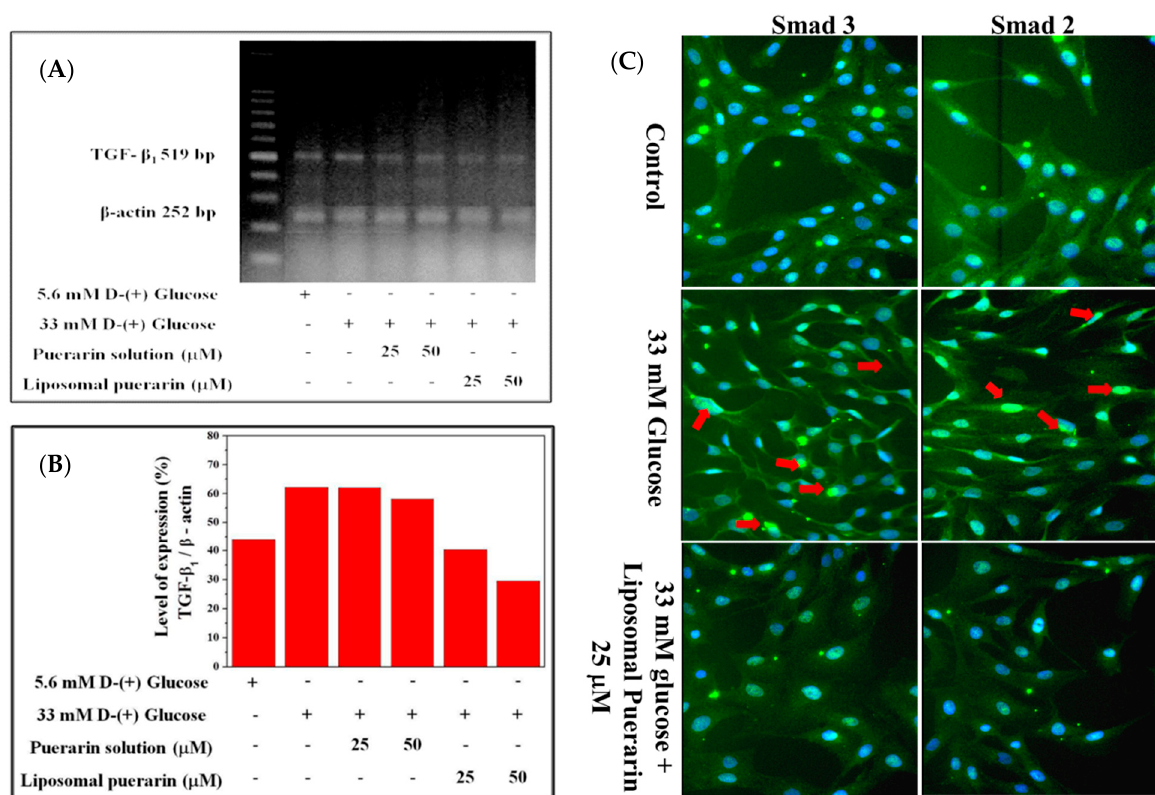
Figure 6. The effect of liposomal puerarin on TGF- β 1 gene expression and the translocation of Smad 2/3 into the nucleus: ( A ) electrophorese of TGF- β 1 gene extracted from RMCs; ( B ) quantitative expression of TGF- β 1 gene; ( C ) fluorescence staining of Smad 2/3 of RMCs. Magnification: 400 × . Control (1st row of Figure 6C): the nucleus of RMCs was stained with Hoechst 33258 (blue) and the cytoplasm was stained with antibodies of Smad 2/3 (green). When 33 mM of glucose were added, both Smad 2/3 proteins translocated in the nucleus, marked with red arrows (2nd row of Figure 6C). When 25 μ M of liposomal Puerarin were used, the proteins were mainly found in cytoplasm (3rd row of Figure 6C).